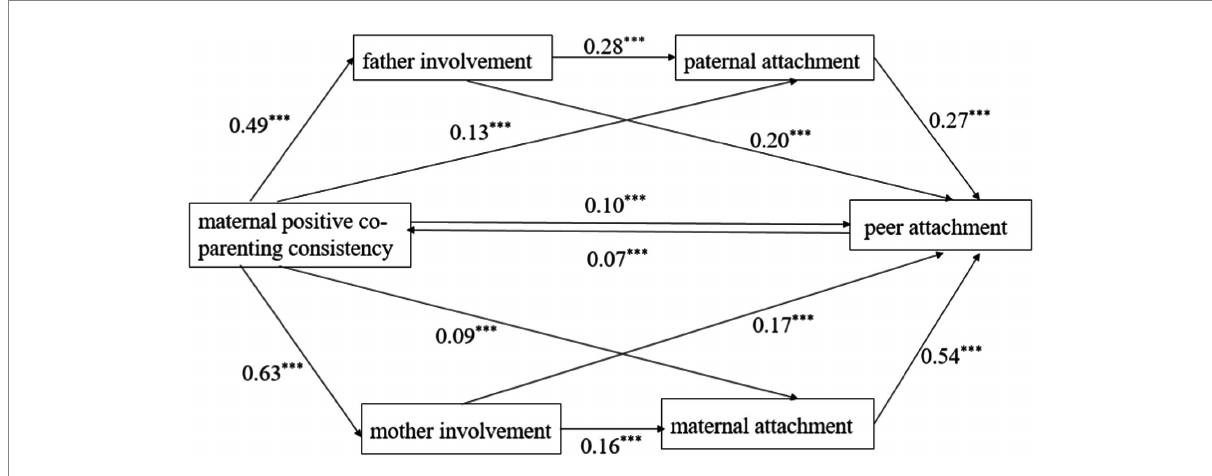
FIGURE 2 Chain mediating of parenting involvement and parent-child attachment between maternal positive co-parenting consistency and peer attachment. *** p <